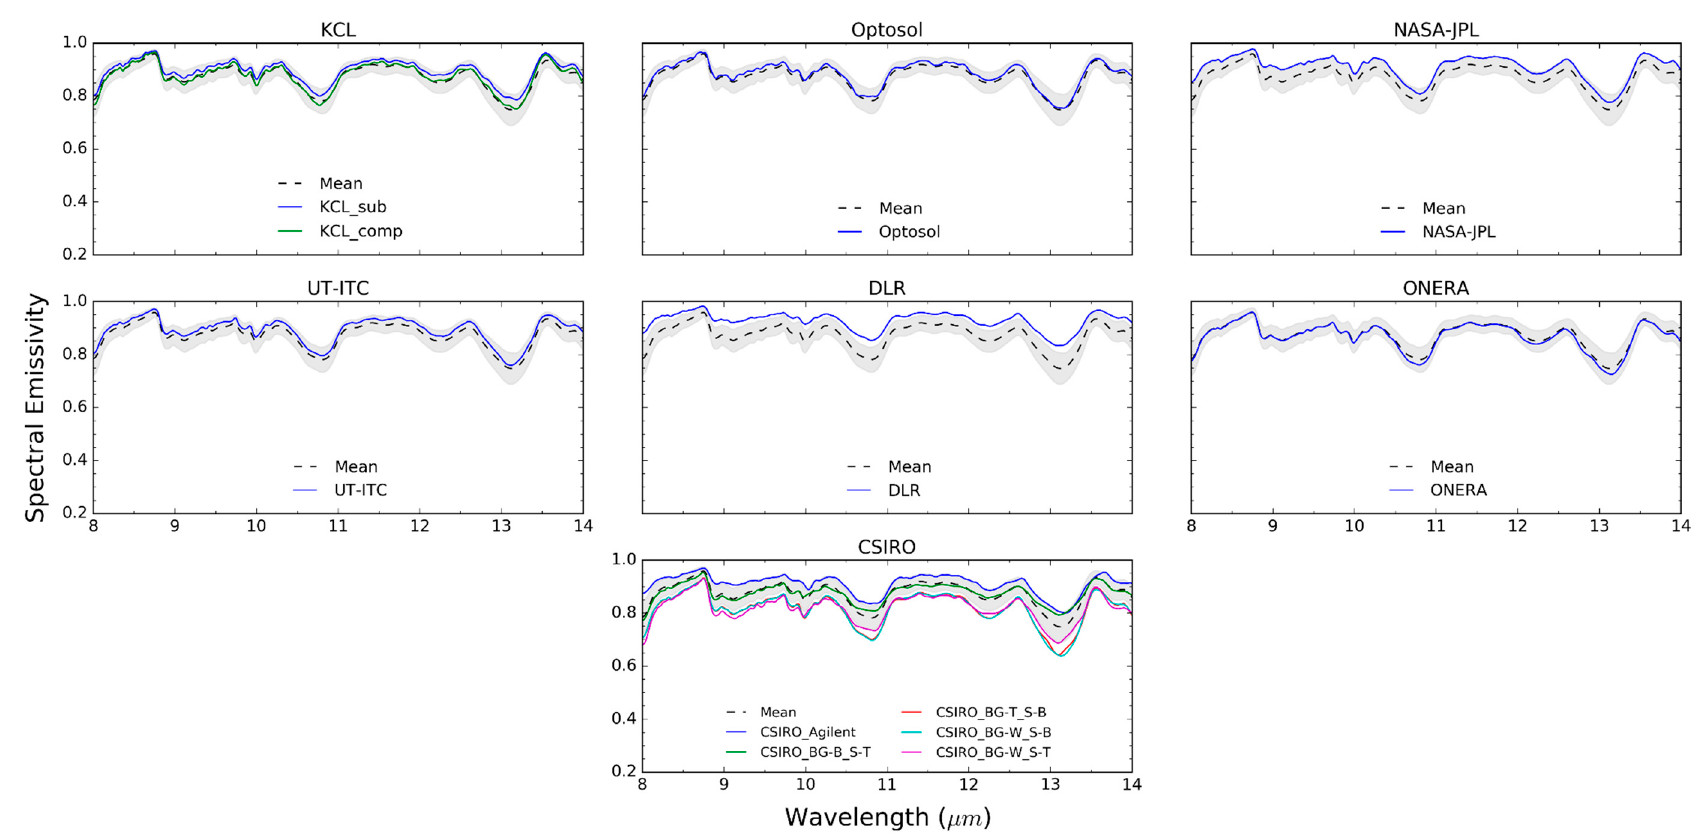
Figure 8. Measured SEs for Sample 2 from each participating laboratory, derived at a 4 cm − 1 spectral resolution across 8–14 µ m and presented against the mean and standard deviation of all SE measurements, shown as the black dashed line and grey shaded area respectively.